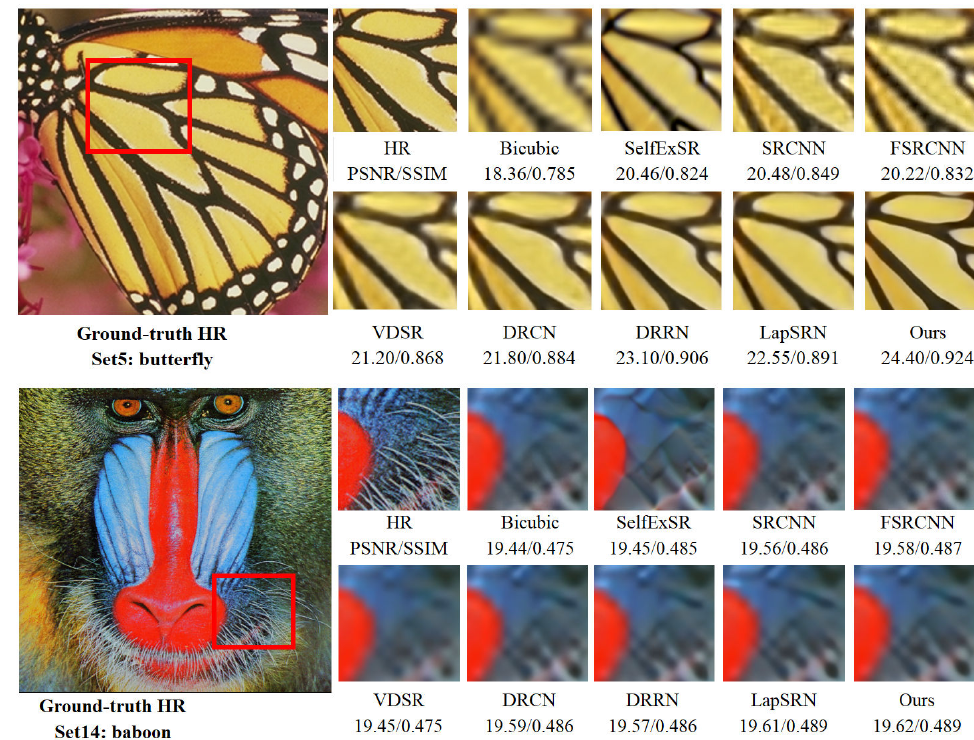
Figure 14. Presents the visual quality performance comparison for 8 × image SR methods on Set5 and Set14